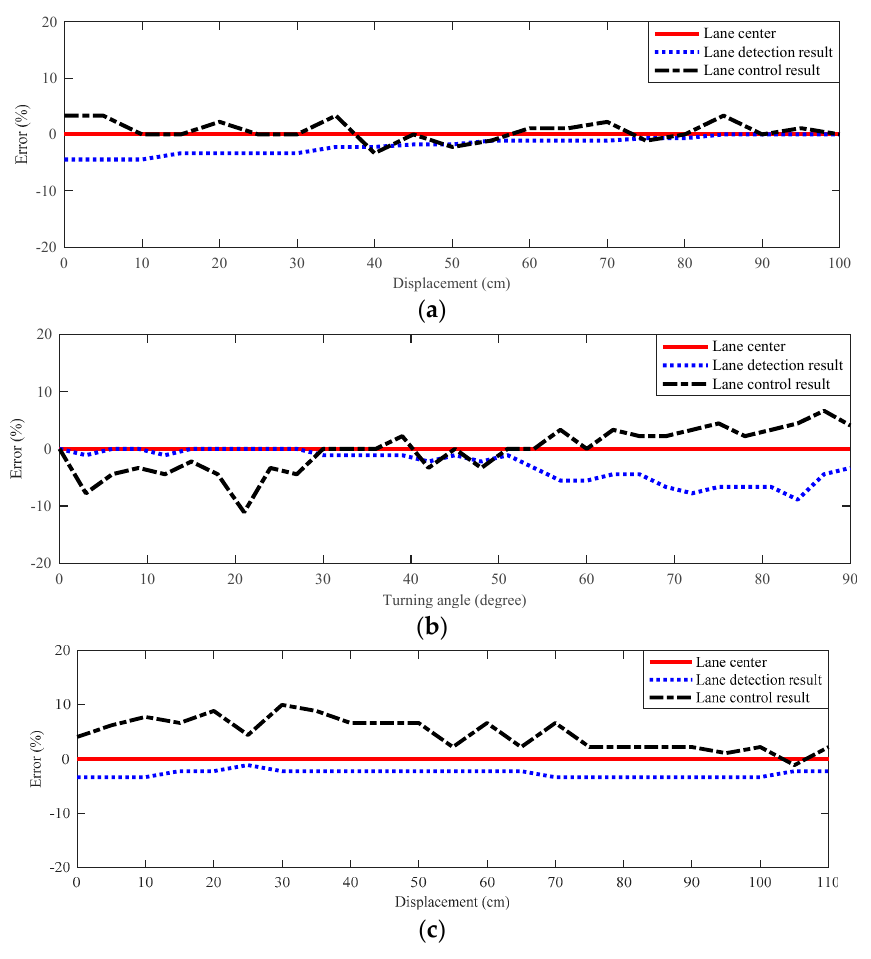
Figure 8. Error percentage in the experimental results of the image sensor in lane keeping system ( a ) before, ( b ) during, and ( c ) after the turning section, where the error percentage is defined as the ratio of the offset from the lane center to the lane width.